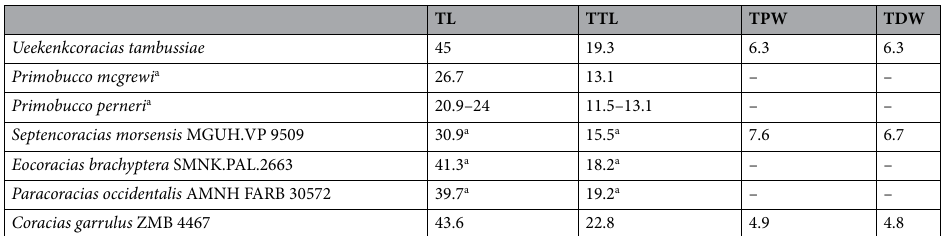
Table 1. Measuremetns (mm) in Ueekenkcoracias tambussiae gen. et sp. nov. (MPEF-PV 10991) compared with other Coracii. TL tibiotarsus length, TTL tarsometatarsus length, TDW tarsometatarsus distal width, TPW tarsometatarsus proximal width. a From Ref. 9 .